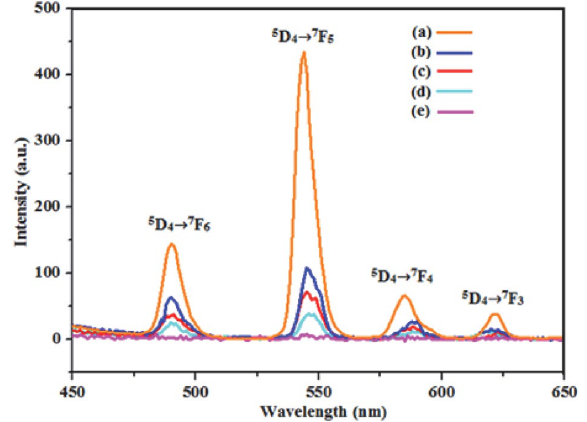
Figure 13. Emission spectra of (a) YbPO 4 :Tb 3+ (Sac) (b) Yb-